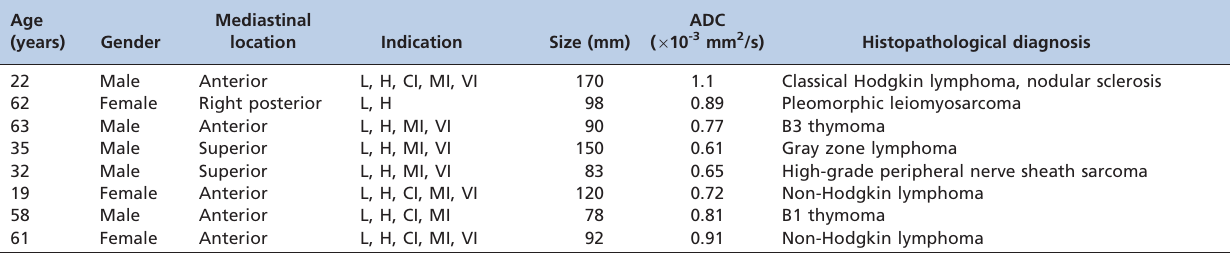
Table 1 - Characteristics of patients with mediastinal lesions who underwent transthoracic biopsy based on magnetic resonance imaging